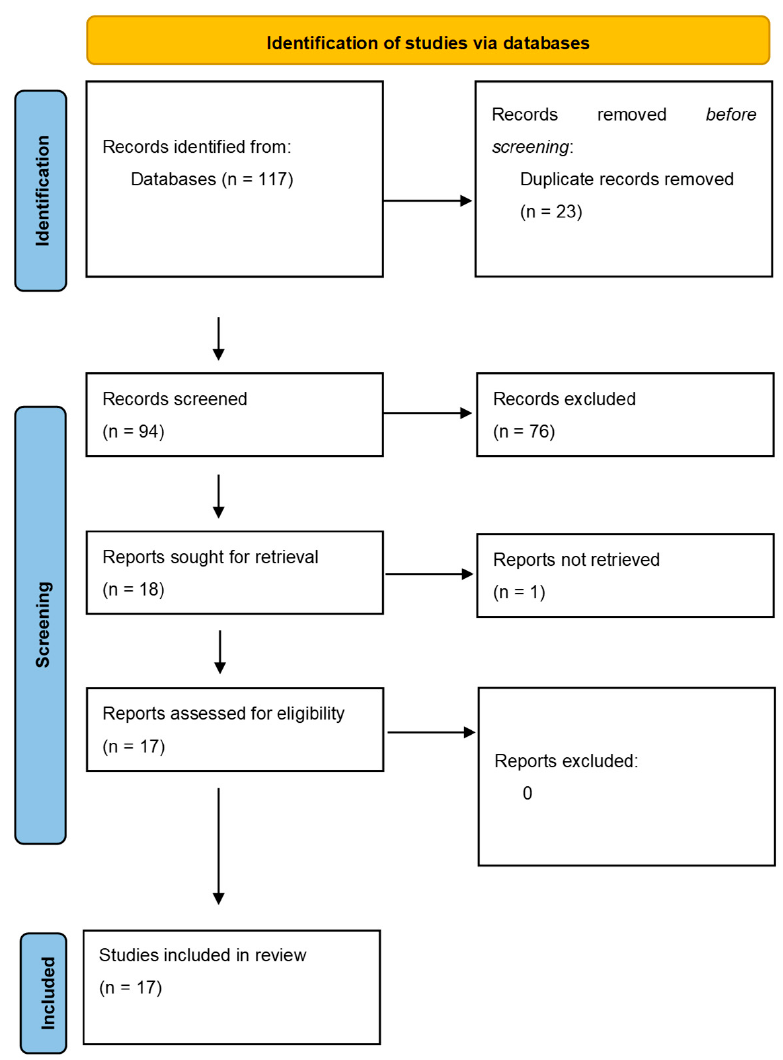
Figure 1. Articles selection and flowchart of the review.